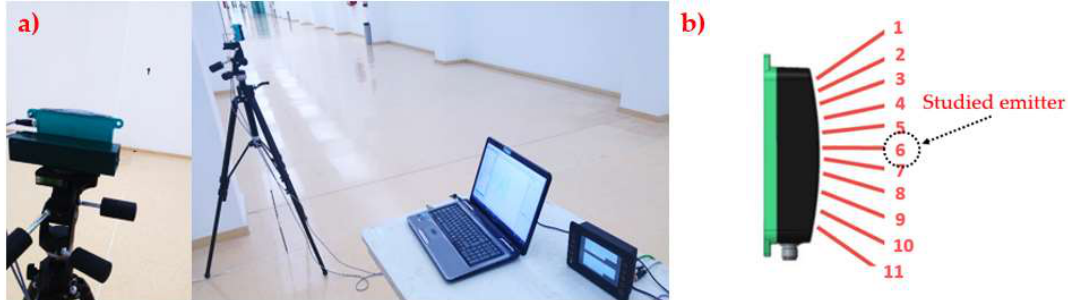
Figure 3. ( a ) Sensor arrangement for accuracy laboratory test, ( b ) tested LED emitters.